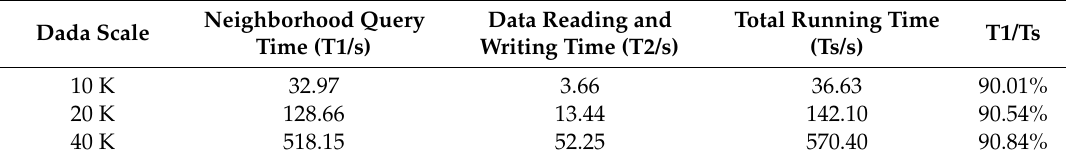
Table 1. Hotspots analysis test on the serial DBSCAN